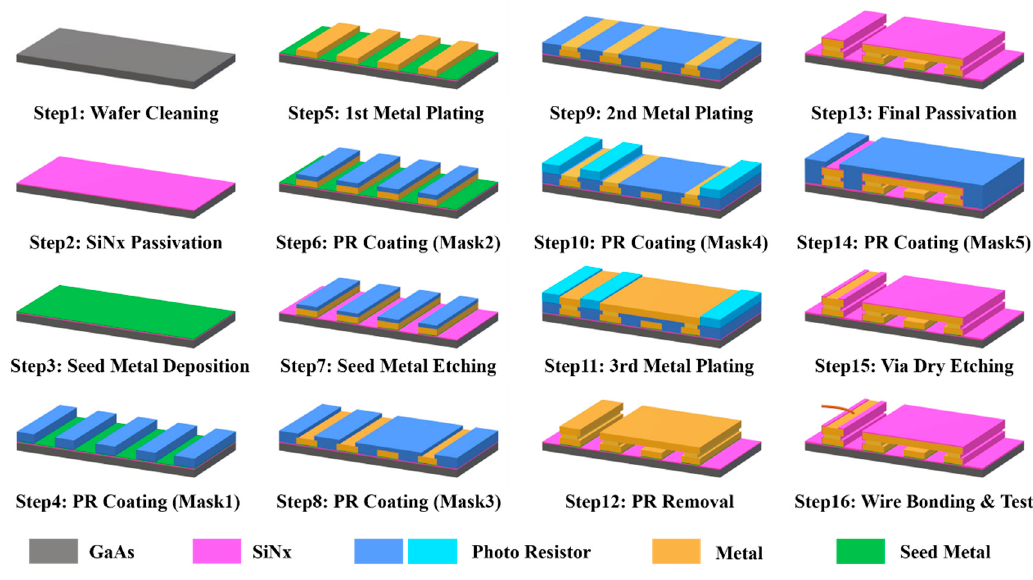
Figure 4. GaAs-based IPD technology fabrication flow.